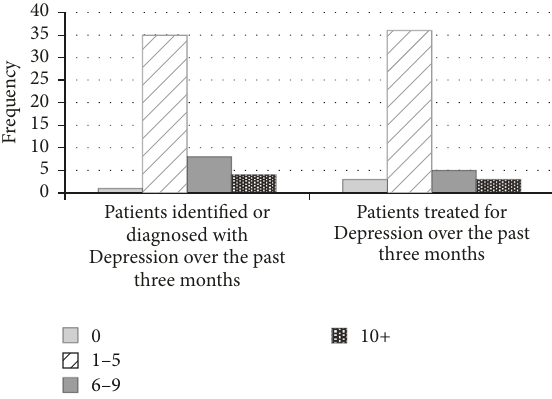
Figure 2: Confidence scores of HCP over time. Error bars represent ± 1 SD. ∗∗ 𝑝 ≤ 0.005 . ∗∗∗ 𝑝 ≤ 0.001 .